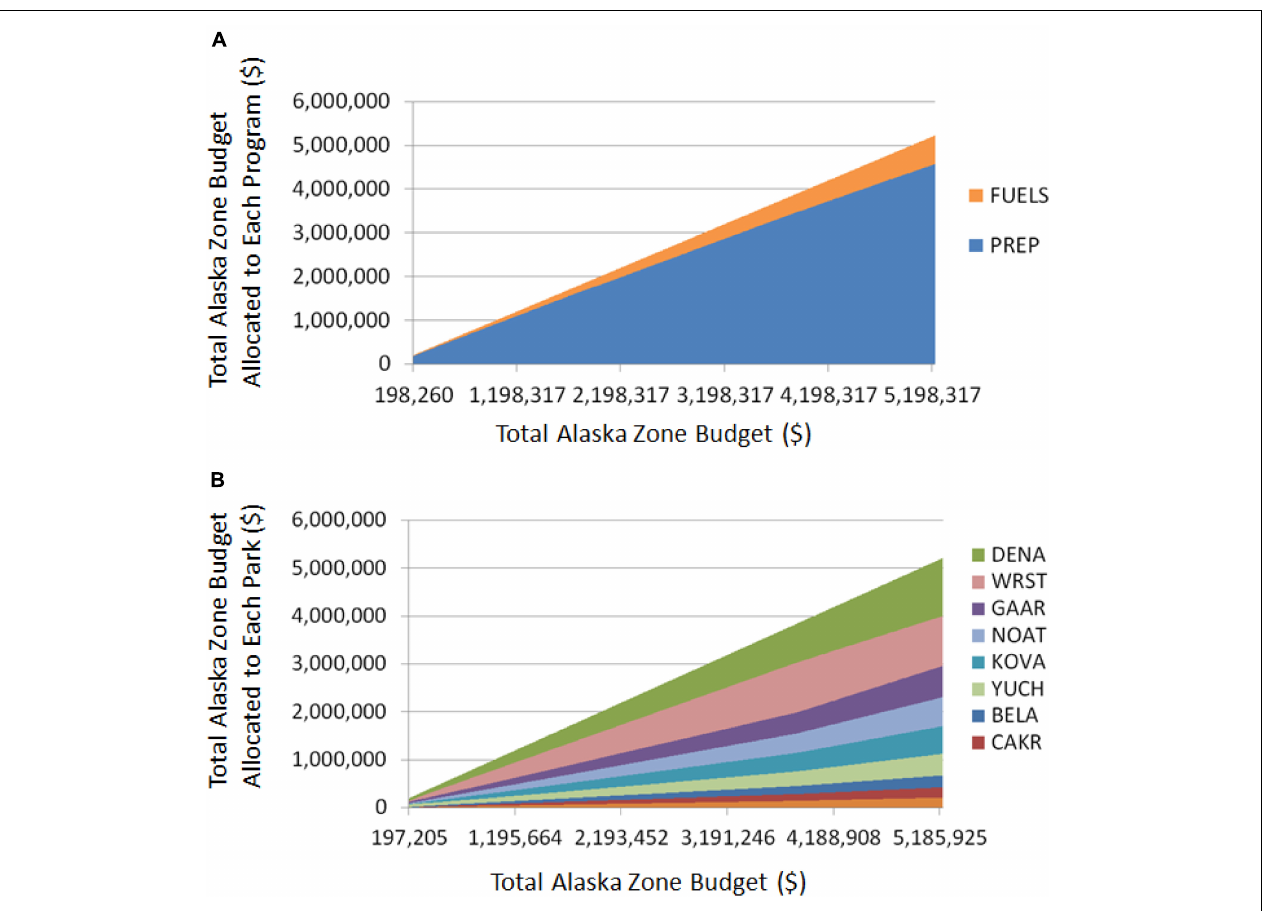
FIGURE 6 | Total Alaska zone budget allocations to each (A) program and to each park (B) .